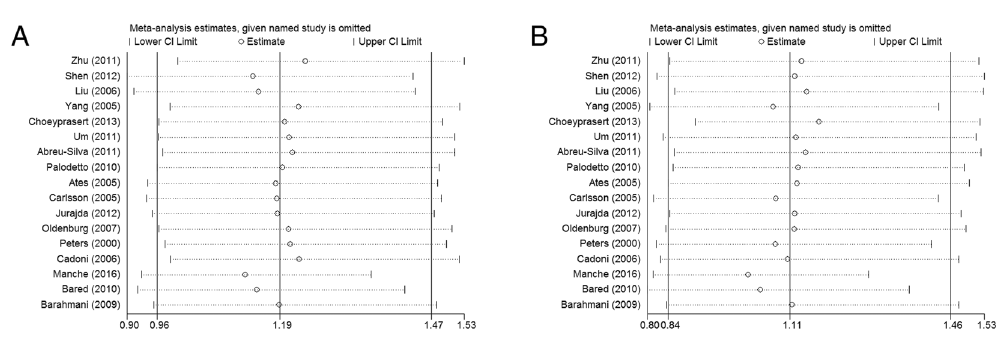
Figure 5. Sensitivity analysis of the pooled effect size on the association between GST M1 ( A ) and T1 ( B ) polymorphisms and the susceptibility to acquired